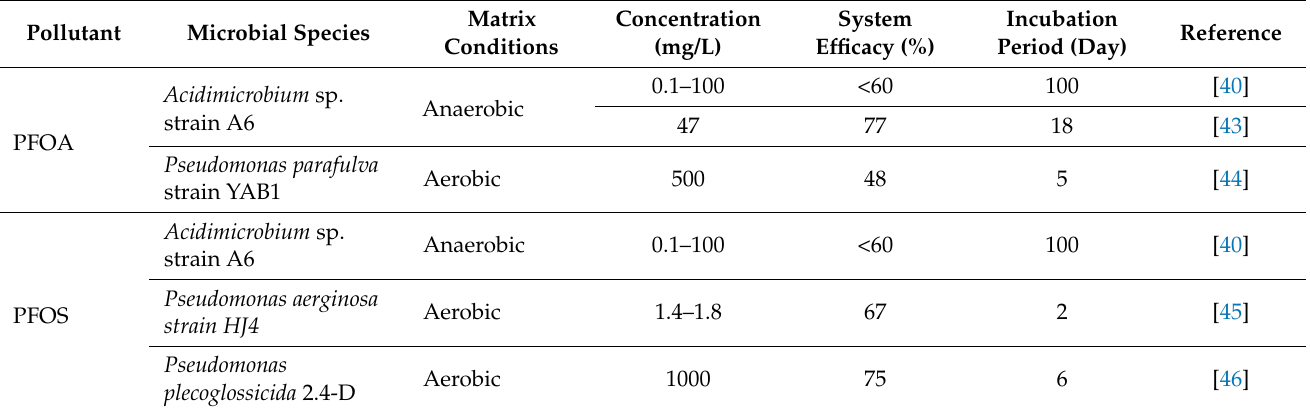
Table 3. Microbial degradation of PFOA and